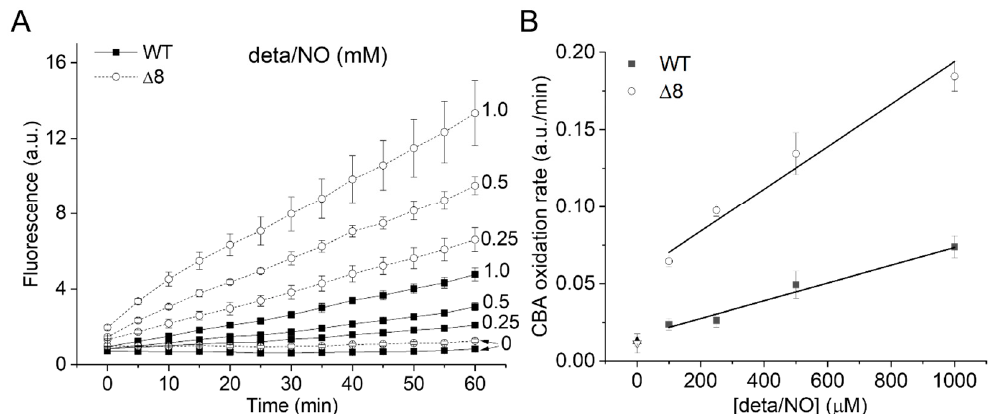
Figure 3. CBA oxidation in suspensions of WT and ∆ 8 S. cerevisiae cells as a function of NO · donor concentration. Fluorescence traces of CBA oxidation ( A ) and CBA oxidation rate ( B ) by peroxynitrite as a function of deta / NO concentration (0.1–1 mM). Suspensions of WT and ∆ 8 S. cerevisiae cells (20 × 10 6 cells per well) were transferred to 96 well plates containing CBA (10 µ M), and were exposed to paraquat (10 µ M) and increasing concentrations of the deta / NO. Fluorescence measurements were recorded every five minutes for 60 min by a plate reader. The experimental conditions and fluorescence acquisition parameters are described in the Figure 1 legend.